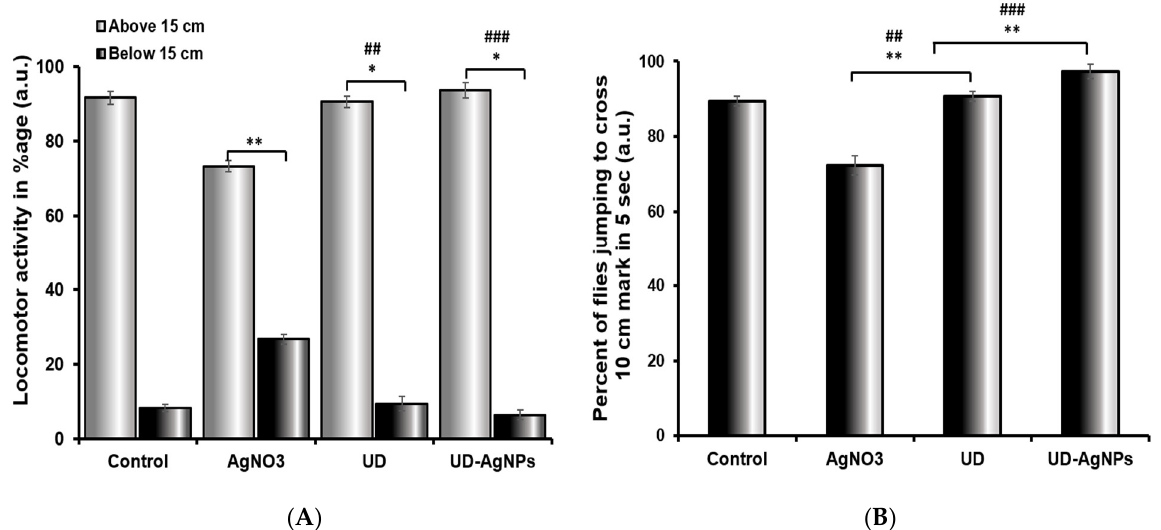
Figure 10. Climbing ( A ) and jumping ( B ) activity of Drosophila melanogaster (Oregon R + ) flies exposed to AgNO 3 , UD, and UD-AgNPs for 120 h. The data are shown as the mean ± SD ( n = 3). Significance is ascribed as * p < 0.05 and ** p < 0.01 vs. control. ## ascribed as significance at p < 0.01 and ### p < 0.0001 compared with AgNO 3 . AgNO 3 = silver nitrate, UD = Urtica dioica , and UD-AgNPs = biosynthesized silver nanoparticles of Urtica dioica.